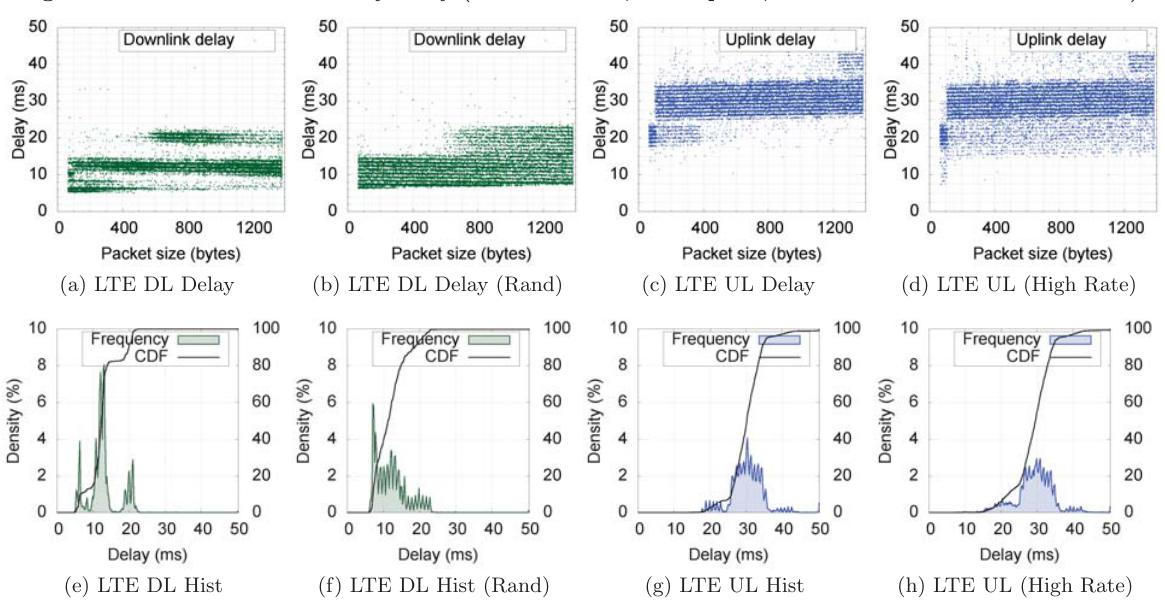
Figure 4: HSPA network one-way delay (DL: Downlink, UL: Uplink, Rand: Server-based randomness).